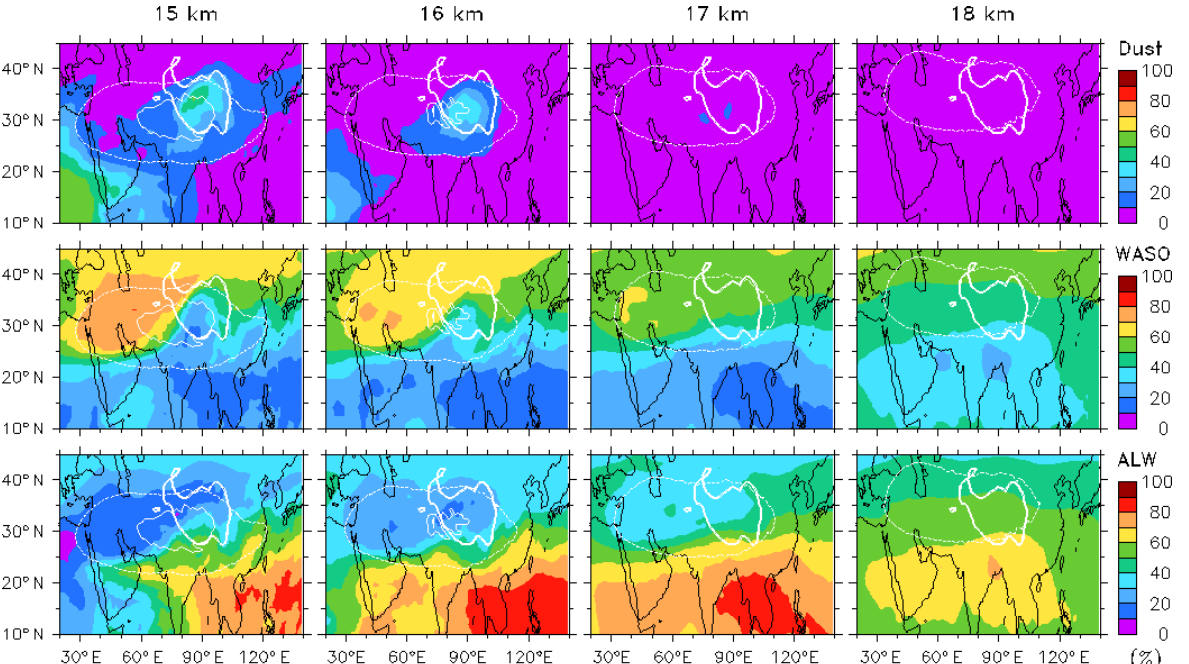
Figure 6. Percent contributions of mineral dust (top), water-soluble species (WASO) (middle), and aerosol liquid water (ALW) (bottom) to the total aerosol extinction coefficient at altitudes of 15, 16, 17, and 18kma.s.l. (first to fourth columns), during July–August 2011. Thin white lines indicate the anticyclone area, with the same index as used in Fig. 2, and thick white lines highlight the Tibetan Plateau